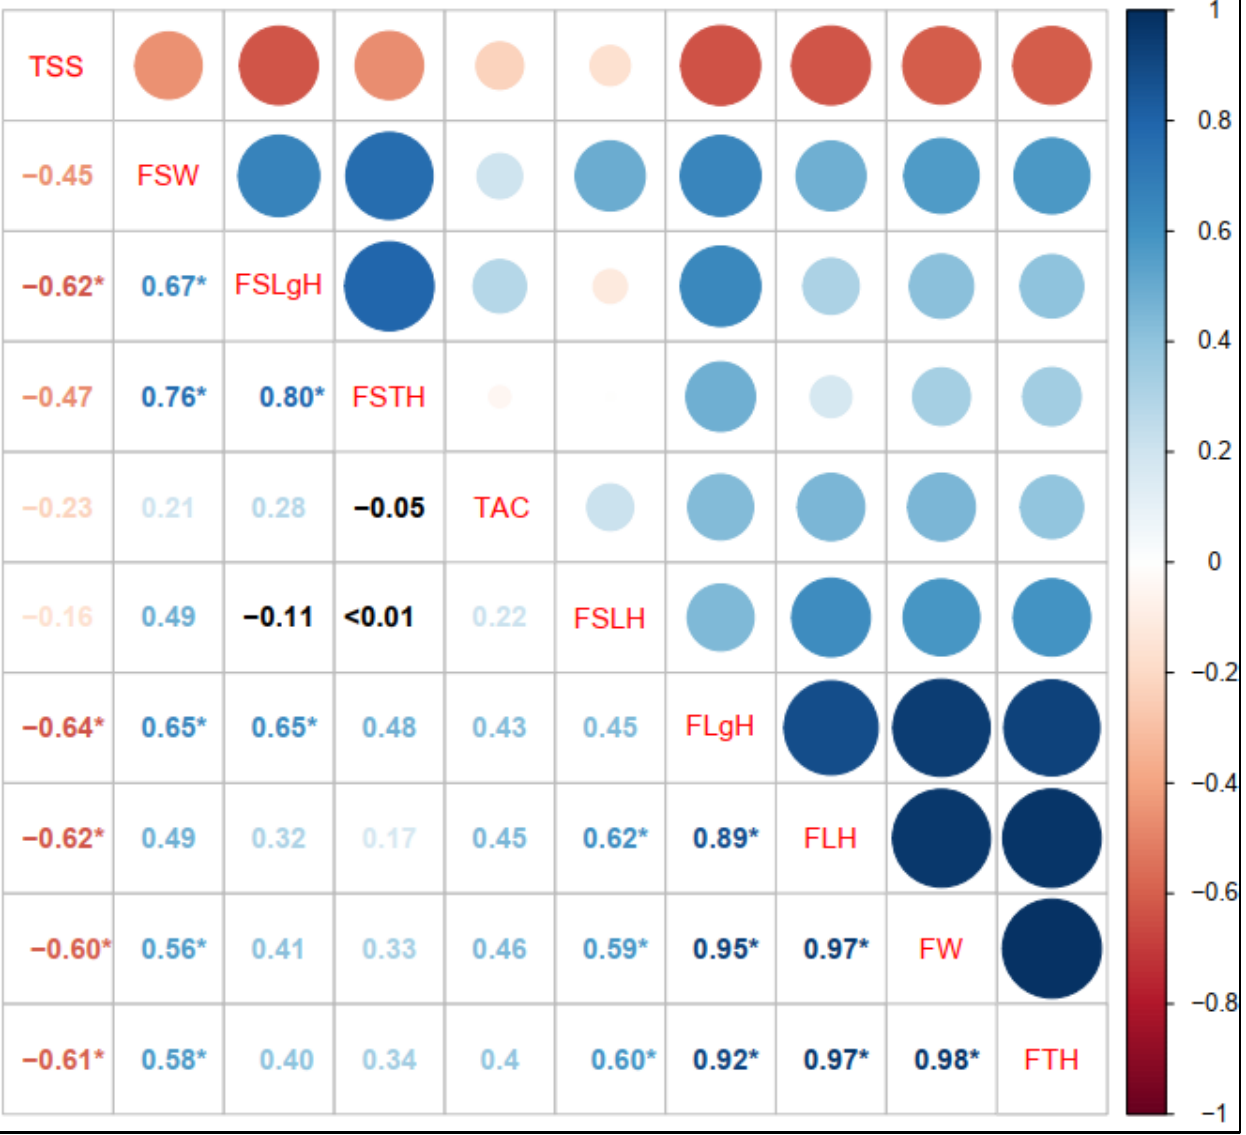
Figure 4. Correlation coefficient matrix showing associations of fruit quality traits among the 10 accessions of Prunus mume. Fruit quality parameters: total soluble solids (TSS), fruit stone weight (FSW), fruit stone longitudinal height (FSLgH), fruit stone transversal height (FSTH), titratable acid content (TAC), fruit stone lateral height (FSLH), fruit longitudinal height (FLgH), fruit lateral height (FLH), fruit weight (FW) and fruit transversal height (FTH). The correlation coefficients with asterisks (*) indicate significance at two-tailed p < 0.05.